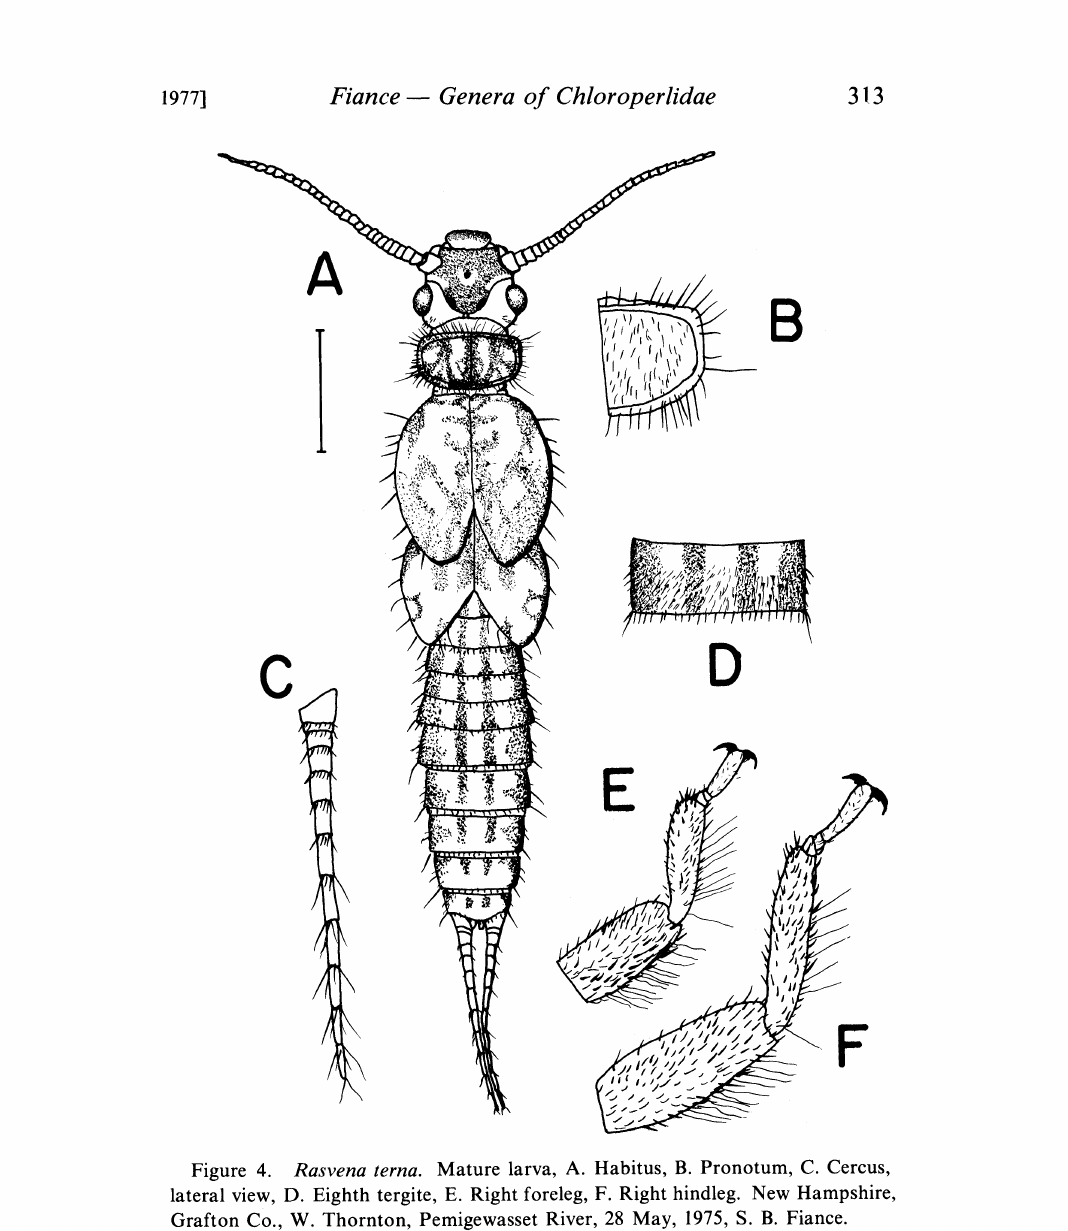
Figure 4. Rasvena terna. Mature larva, A. Habitus, B. Pronotum, C. Cercus, lateral view, D. Eighth tergite, E. Right foreleg, F. Right hindleg. New Hampshire, Grafton Co., W. Thornton, Pemigewasset River, 28 May, 1975, S. B.